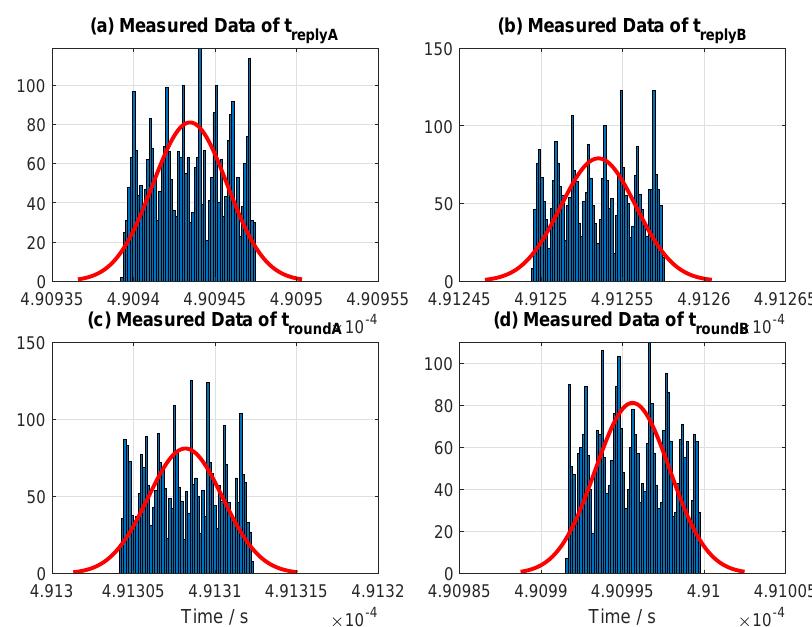
Figure 7. Measured data for fixed reply times used in the experiments for the special case (Type II)